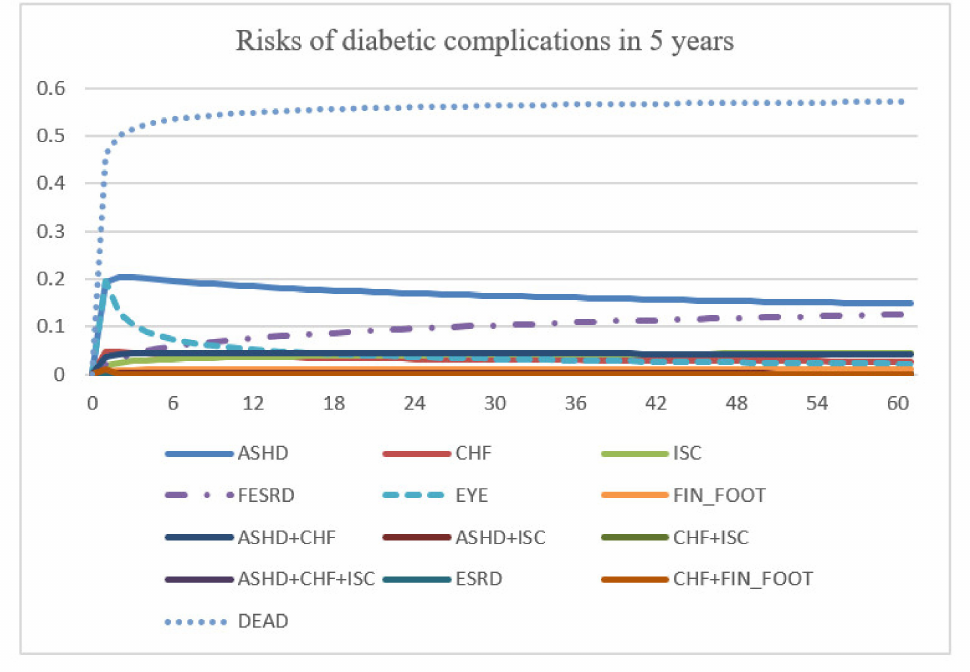
Figure A1. Risks of diabetic complication in 5